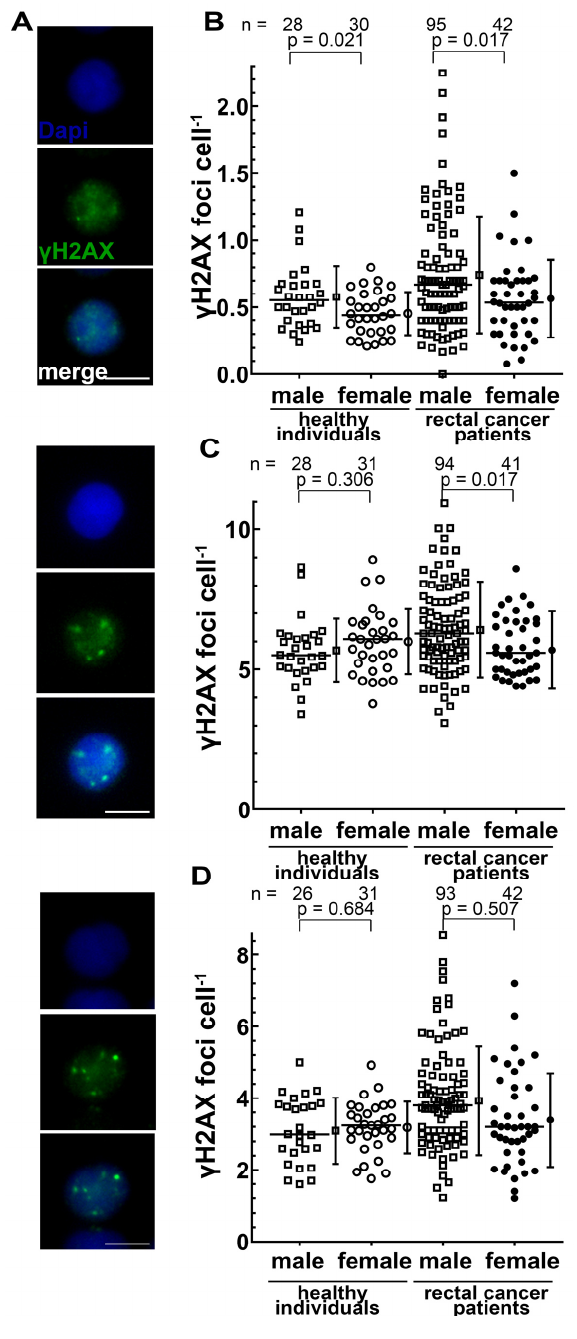
Figure 4. Number of DNA double-strand breaks per lymphocyte quantified by γ H2AX after im- munostaining of lymphocytes from healthy individuals and patients with rectal cancer (radiosensitiv- ity cohort): ( A ) Representative images of an unirradiated cell, a 0.5 Gy irradiated cell with 30 min and a 2 Gy irradiated cell with 24h repair time. Blue staining is dapi and green staining is γ